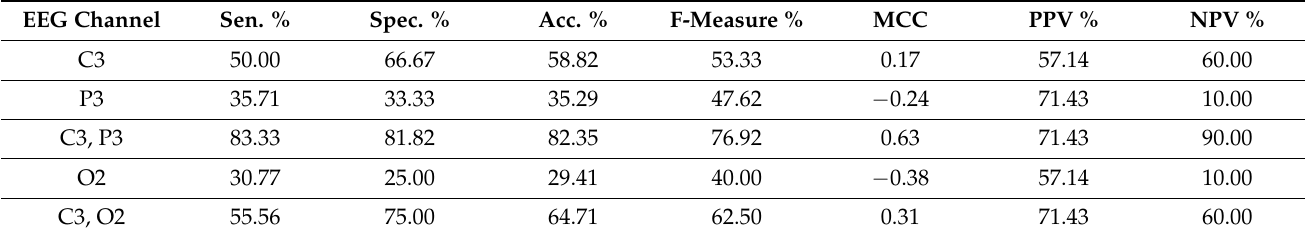
Table 10. The performance of the alpha band for the TsEn